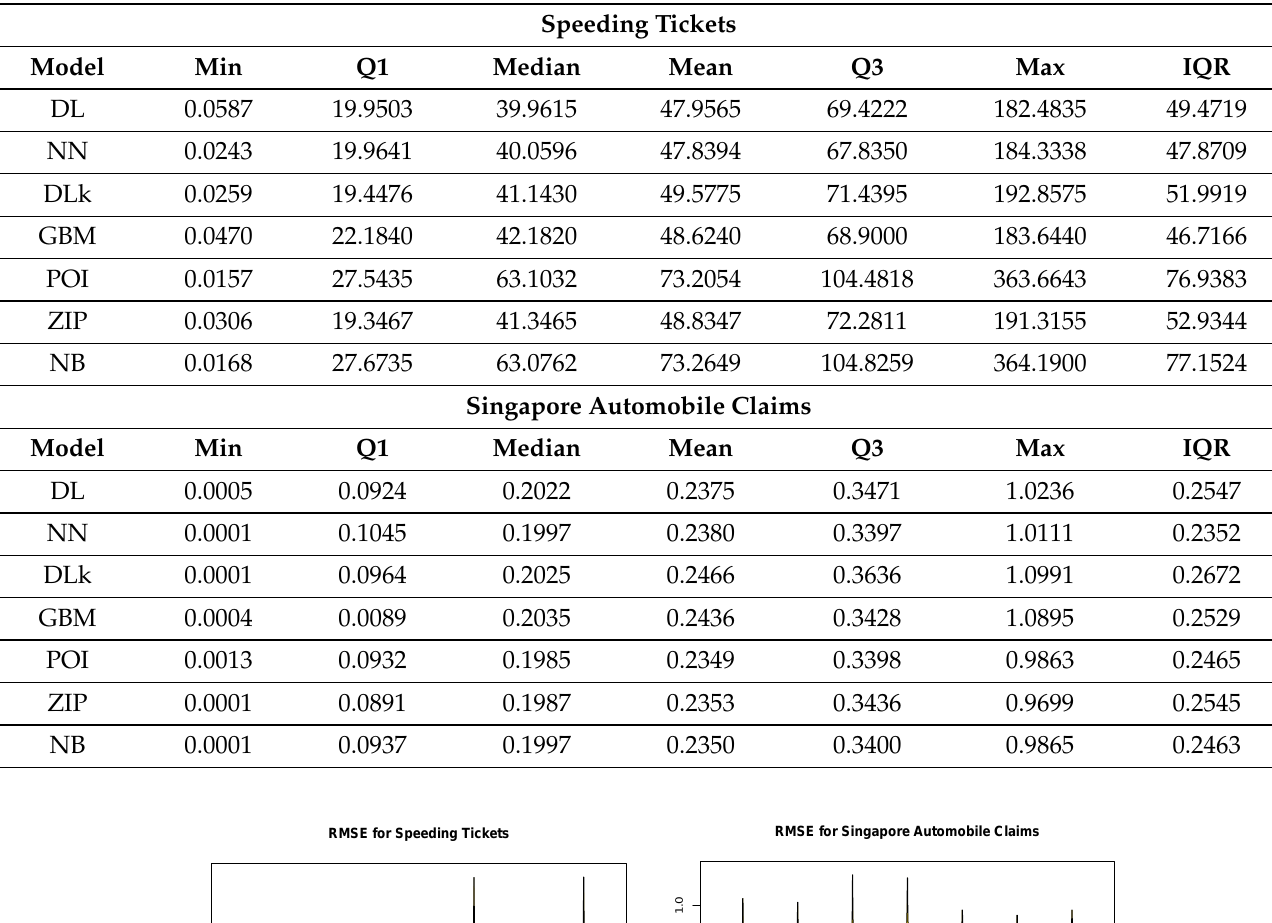
Table 4. RMSE of speeding ticket data and Singapore automobile claims with 1000 repetitions.